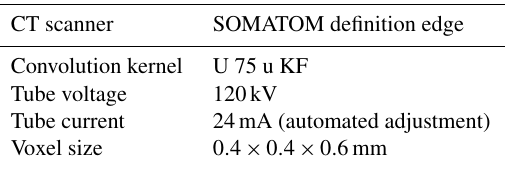
Table 1. Standard uncertainties of the measuring method for differ- ent measuring tasks.